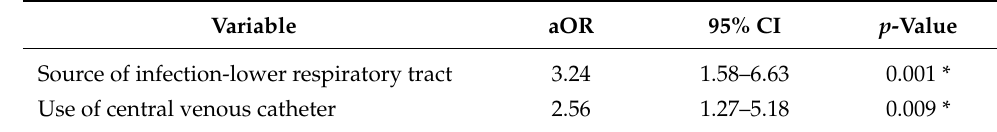
Table 2. Final model of multivariate analysis showing the risk factors of bacteremia due to